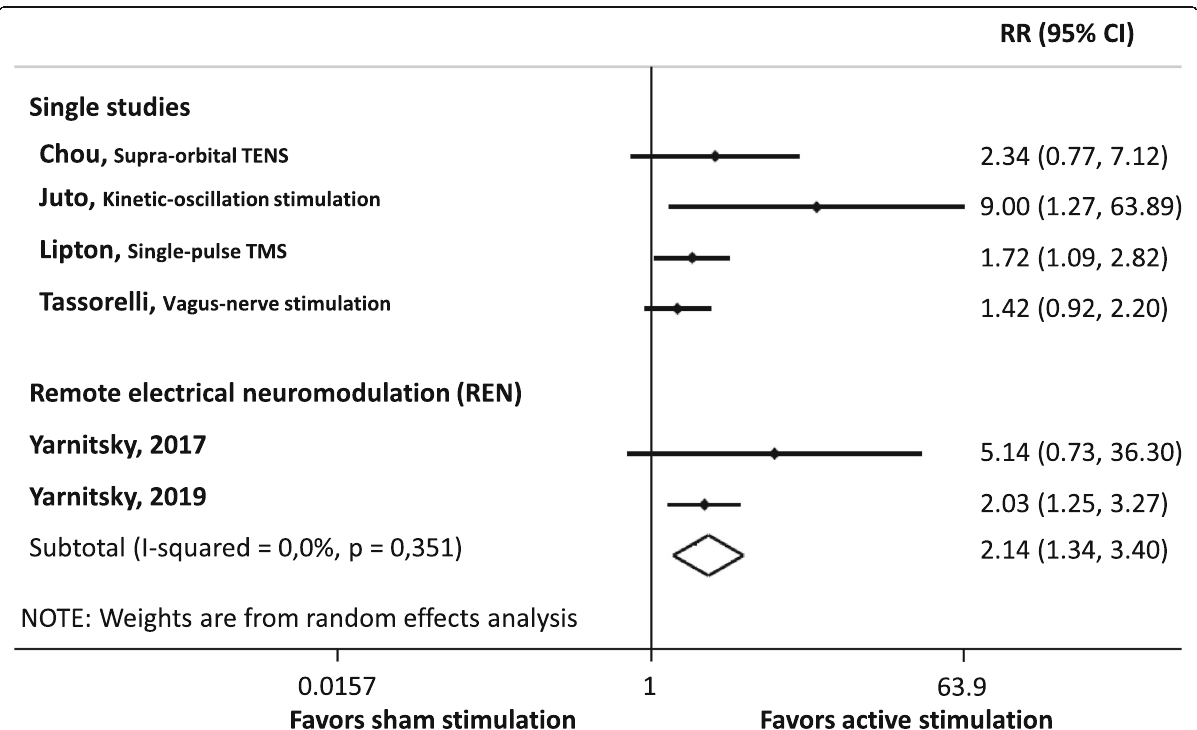
Fig. 2 Forest plot of the six studies included in the quantitative synthesis for acute migraine treatment. The common outcome for these six studies was the proportion of patients who were pain free after 2 h in the active treatment and control groups (the higher the relative risk, the more effective the treatment). All references for studies in this figure are listed in the online supplementary references. RR: relative risk, TENS: transcutaneous electrical nerve stimulation, TMS: transcranial magnetic stimulation. The study by Hokenek et al. of 2020 [16] (supra-orbital TENS), was not included in the quantitative